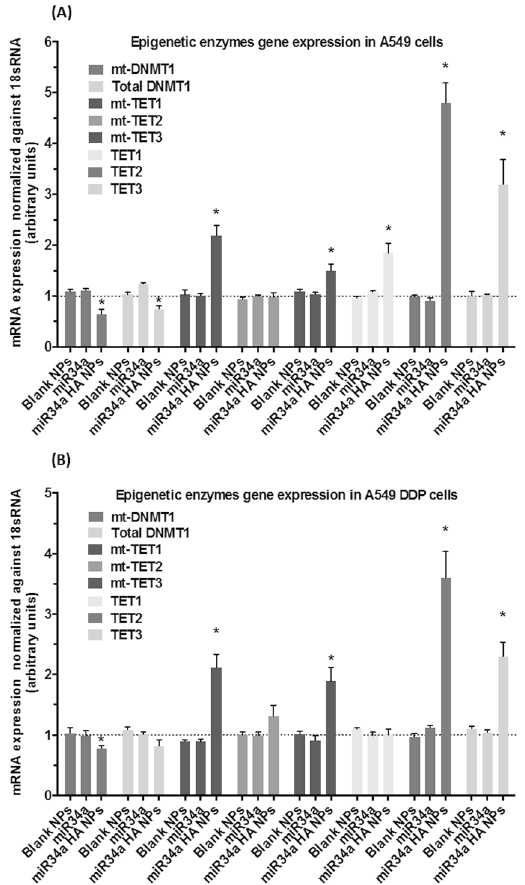
Figure 3. Effect of miR34a transfection with HA-based nanoparticles on mRNA content of epigenetic enzymes in cellular and mitochondrial (mt) compartment. A quantitative real time polymerase chain reaction (qRT-PCR) assay was for measurement of epigenetic enzyme levels in ( A ) wild-type A549 and ( B ) cisplatin resistant A549DDP cells post-transfection with HA-PEI/PEG-nanovectors encapsulated miR34a. The levels were normalized to beta-actin for nuclear genes and 18 s ribosomal RNA for mitochondrial genes, as well as untreated A549 or A549 DDP control cells using relative quantification by delta(delta(Ct) method. Mitochondrial DNA methyltransferase (mt-DNMT1), Total-DNA methyltransferase (Total-DNMT1), mitochondrial Ten-Eleven-Translocase 1–3 (mt-TET1–3), total TET1–3 (TET1–3). Blank NPs–Blank HA-PEI/ HA-PEG Nanoparticles, miR34a - Naked miR34a without encapsulation, miR34a HA-NPs–microRNA34a encapsulated in HA-PEI/HA-PEG nanoparticles. Results are expressed in units (mean + / − standard error of mean [SEM]); * indicates comparison against control = 1. One-way ANOVA followed by Post-hoc t-test with multiple comparisons, * p < 0.05; N =